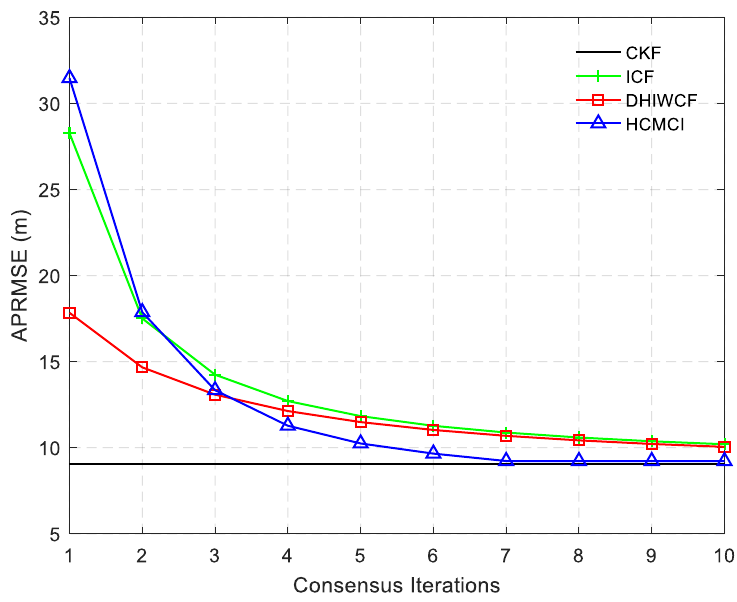
Figure 11. APRMSE for di ff erent algorithms under discussion.